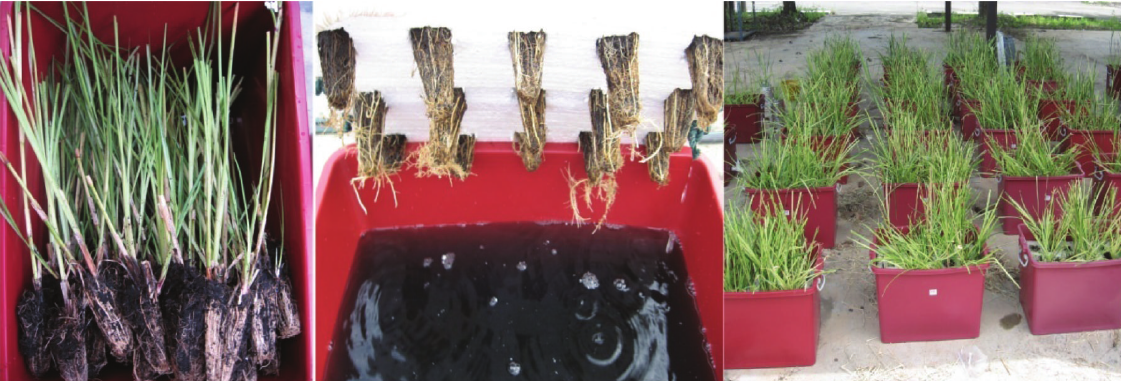
Figure 2: Vetiver planting slips in hydroponic solution.